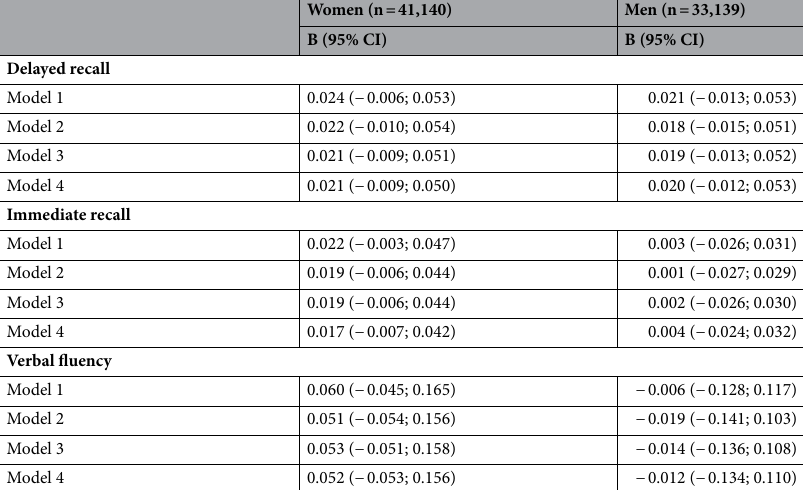
Table 4. Association of childhood socioeconomic advantage with the rate of cognitive decline. * p < 0.05, ** p < 0.01, *** p < 0.001. Model 1 adjusted for age and practice effect. Model 2 adjusted for age, practice effect and education. Model 3 adjusted for age, practice effect, education, depressive symptoms and socioeconomic characteristics (household net worth, cohabitation status, number of children, number of grandchildren and current working status). Model 4 adjusted for age, practice effect, education, socioeconomic characteristics (household net worth, cohabitation status, number of children, number of grandchildren, current working status) and health related characteristics (body mass index, depressive symptoms, limitations in instrumental activities of daily living, maximum of grip strength, physical inactivity, number of chronic diseases, smoking status, cardiovascular disease and alcohol